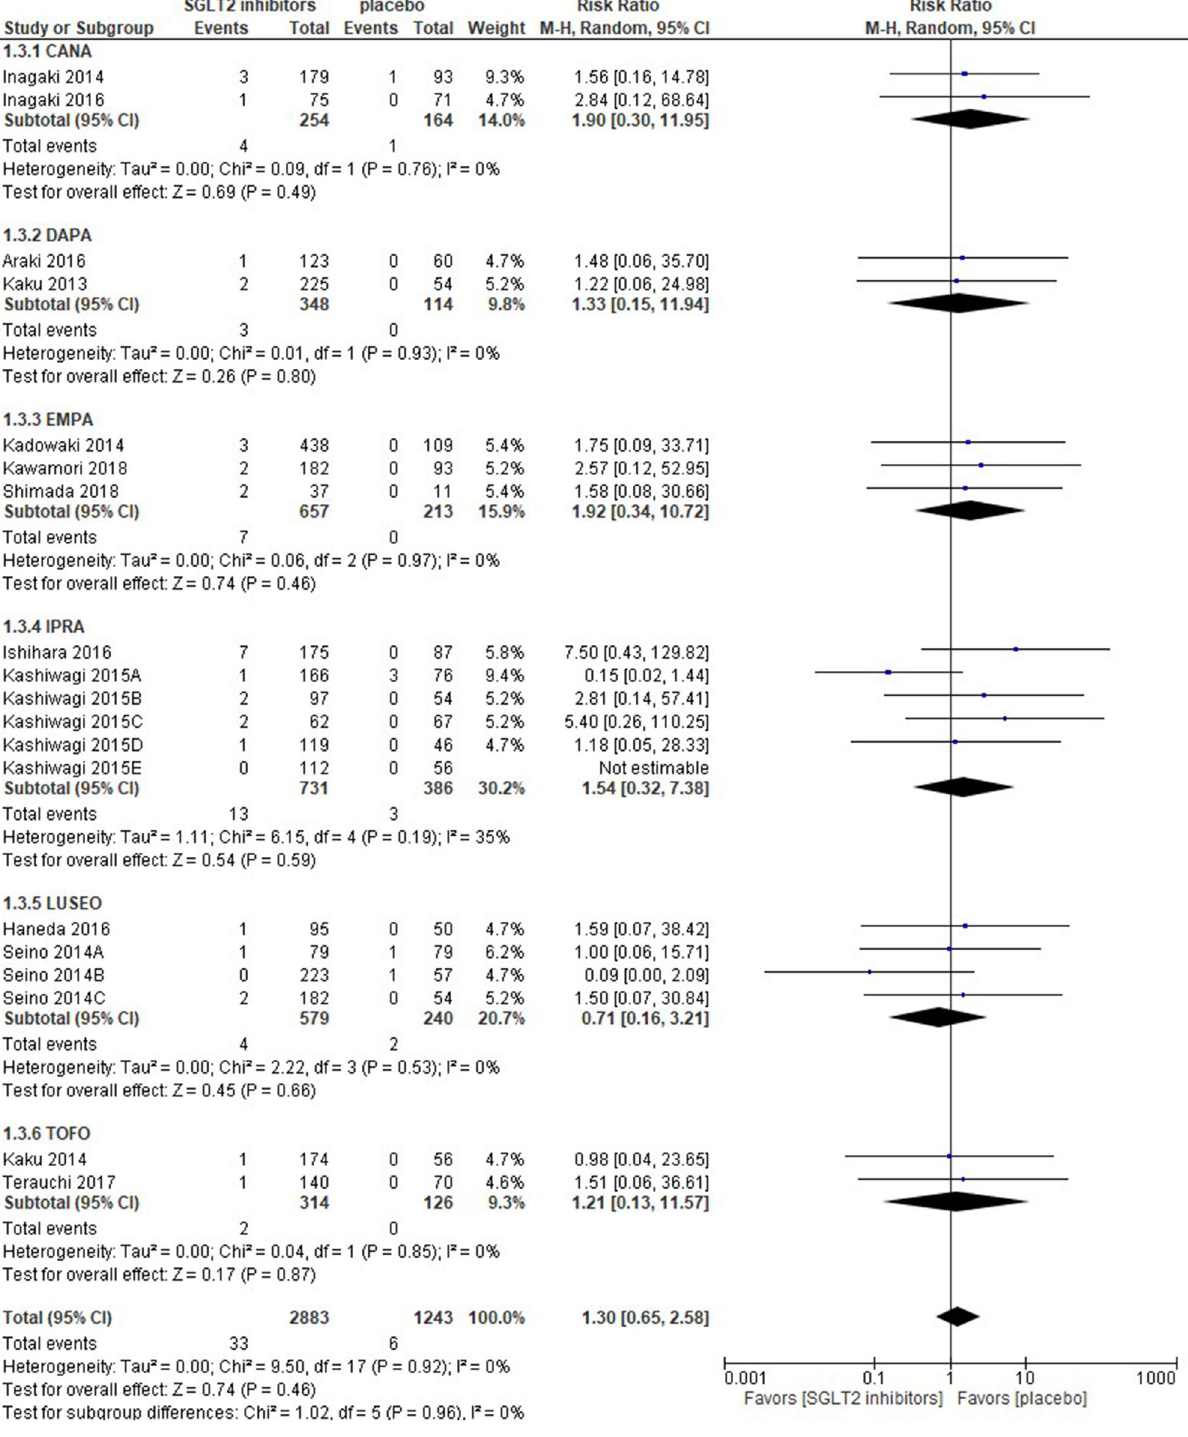
Figure 3. Forest plot for the risk of genital infection. CANA canagliflozin, DAPA dapagliflozin, EMPA empagliflozin, IPRA ipragliflozin, LUSEO luseogliflozin, TOFO tofogliflozin, SGLT2 sodium-glucose co-transporter